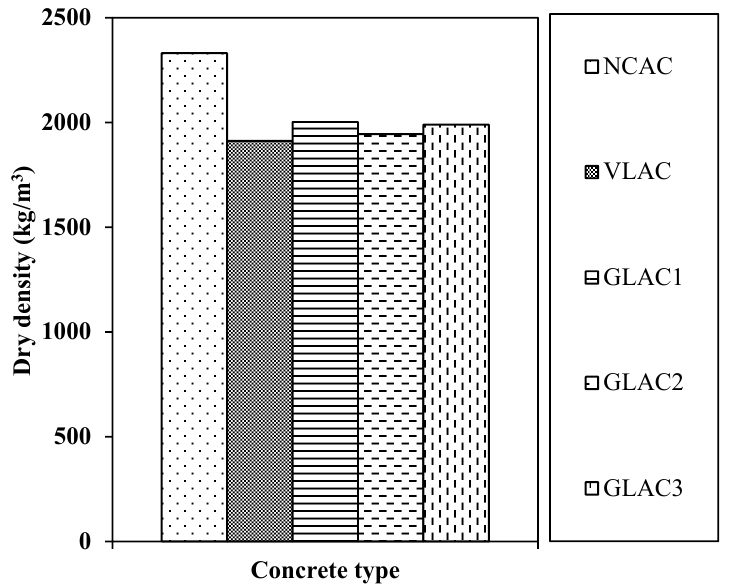
Figure 11. The 28-day dry density of green lightweight aggregate concrete (GLAC), local lightweight concrete (VLAC) and normal weight concrete (NCAC) at W/C of 0.50.